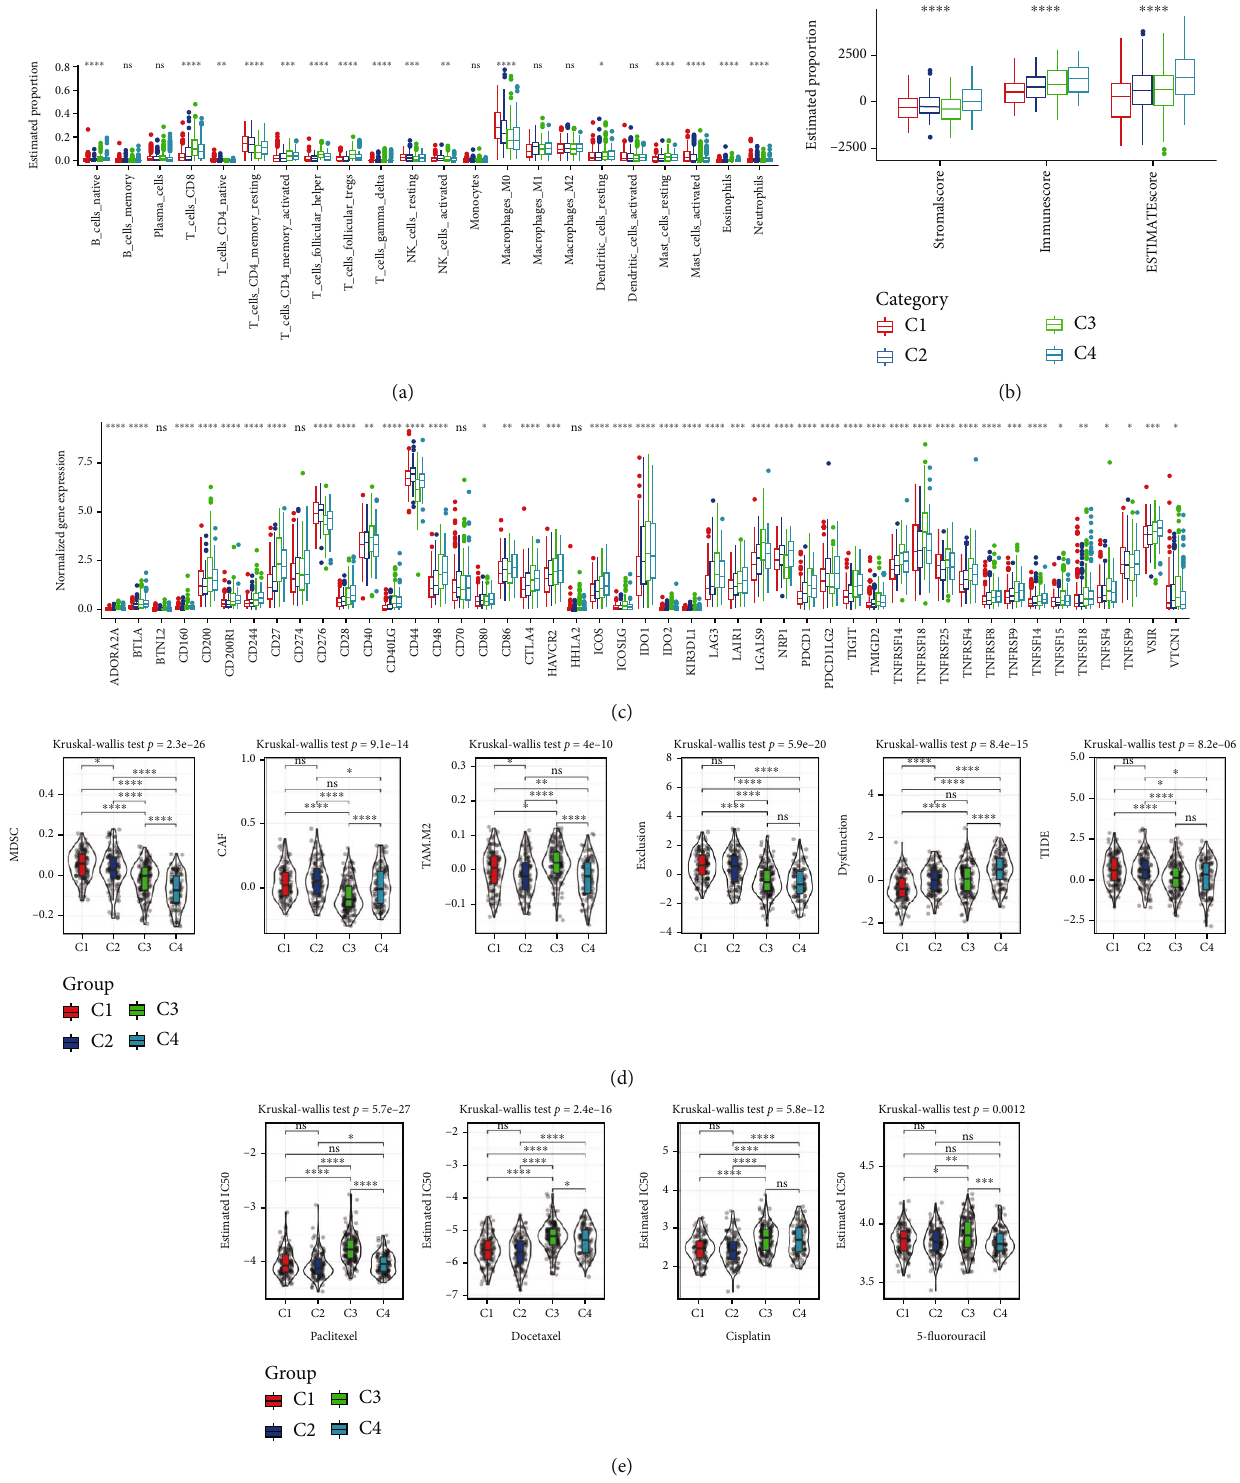
Figure 3: Immune characteristics and immunotherapy/chemotherapy di ff erences between molecular subtypes. (a) The TCGA cohort di ff erences in 22 immune cell scores between molecular subtypes. (b) Di ff erences in ESTIMATE immune in fi ltration between molecular subtypes in the TCGA cohort. (c) Di ff erentially expressed immune checkpoints between subtypes in the TCGA cohort. (d) Di ff erences in TIDE analysis results between di ff erent subgroups in the TCGA cohort. (e) The box plots of the estimated IC50 for paclitaxel, docetaxel, cisplatin, and 5- fl uorouracil in the TCGA